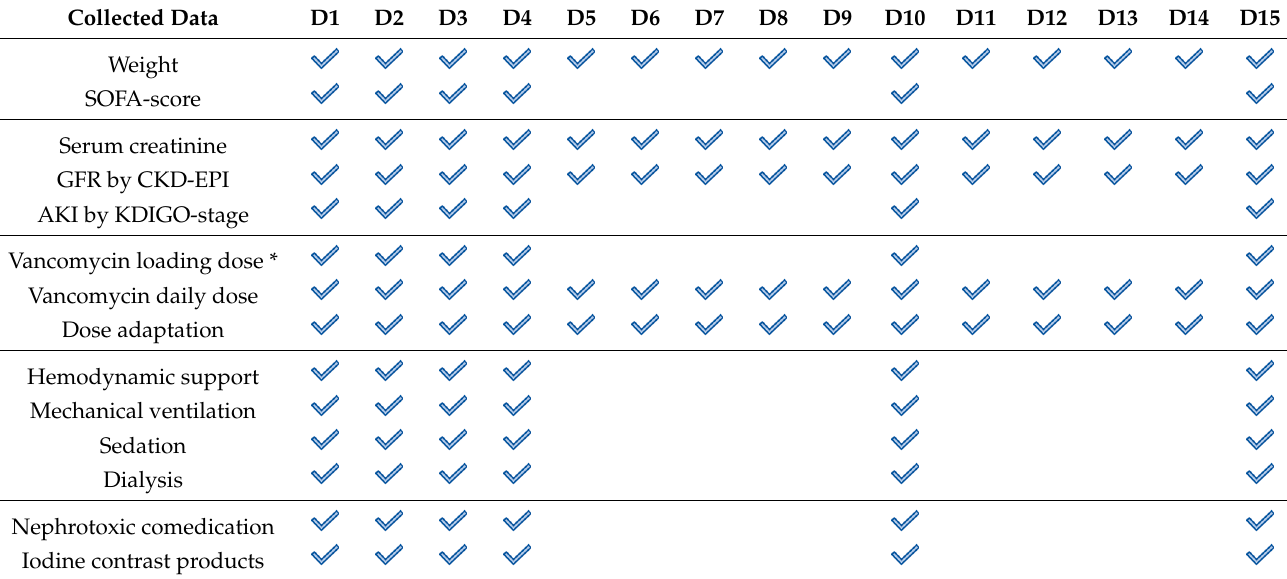
Table 1. Time of measurement of the di ff erent studied parameters. Table 1. Time of measurement of the different studied parameters. Table 1. Time of measurement of the different studied parameters. Table 1. Time of measurement of the different studied parameters. Table 1. Time of measurement of the different studied parameters. Table 1. Time of measurement of the different studied parameters. Table 1. Time of measurement of the different studied parameters. Table 1. Time of measurement of the different studied parameters. Table 1. Time of measurement of the different studied parameters. Table 1. Time of measurement of the different studied parameters. Table 1. Time of measurement of the different studied parameters. Table 1. Time of measurement of the different studied parameters. Table 1. Time of measurement of the different studied parameters. Table 1. Time of measurement of the different studied parameters. Table 1. Time of measurement of the different studied parameters. Table 1. Time of measurement of the different studied parameters. Table 1. Time of measurement of the different studied parameters. Table 1. Time of measurement of the different studied parameters. Table 1. Time of measurement of the different studied parameters. Table 1. Time of measurement of the different studied parameters. Table 1. Time of measurement of the different studied parameters. Table 1. Time of measurement of the different studied parameters. Table 1. Time of measurement of the different studied parameters. Table 1. Time of measurement of the different studied parameters. Table 1. Time of measurement of the different studied parameters. Table 1. Time of measurement of the different studied parameters. Table 1. Time of measurement of the different studied parameters. Table 1. Time of measurement of the different studied parameters. Table 1. Time of measurement of the different studied parameters. Table 1. Time of measurement of the different studied parameters. Table 1. Time of measurement of the different studied parameters. Table 1. Time of measurement of the different studied parameters. Table 1. Time of measurement of the different studied parameters. Table 1. Time of measurement of the different studied parameters. Table 1. Time of measurement of the different studied parameters. Table 1. Time of measurement of the different studied parameters. Table 1. Time of measurement of the different studied parameters. Table 1. Time of measurement of the different studied parameters. Table 1. Time of measurement of the different studied parameters. Table 1. Time of measurement of the different studied parameters. Table 1. Time of measurement of the different studied parameters. Table 1. Time of measurement of the different studied parameters. Table 1. Time of measurement of the different studied parameters. Table 1. Time of measurement of the different studied parameters. Table 1. Time of measurement of the different studied parameters. Table 1. Time of measurement of the different studied parameters. Table 1. Time of measurement of the different studied parameters. Table 1. Time of measurement of the different studied parameters. Table 1. Time of measurement of the different studied parameters. Table 1. Time of measurement of the different studied parameters. Table 1. Time of measurement of the different studied parameters. Table 1. Time of measurement of the different studied parameters. Table 1. Time of measurement of the different studied parameters. Table 1. Time of measurement of the different studied parameters. Table 1. Time of measurement of the different studied parameters. Table 1. Time of measurement of the different studied parameters. Table 1. Time of measurement of the different studied parameters. Table 1. Time of measurement of the different studied parameters. Table 1. Time of measurement of the different studied parameters. Table 1. Time of measurement of the different studied parameters. Table 1. Time of measurement of the different studied parameters. Table 1. Time of measurement of the different studied parameters. Table 1. Time of measurement of the different studied parameters. Table 1. Time of measurement of the different studied parameters. Table 1. Time of measurement of the different studied parameters. Table 1. Time of measurement of the different studied parameters. Table 1. Time of measurement of the different studied parameters. Table 1. Time of measurement of the different studied parameters. Table 1. Time of measurement of the different studied parameters. Table 1. Time of measurement of the different studied parameters. Table 1. Time of measurement of the different studied parameters. Table 1. Time of measurement of the different studied parameters. Table 1. Time of measurement of the different studied parameters. Table 1. Time of measurement of the different studied parameters. Table 1. Time of measurement of the different studied parameters. Table 1. Time of measurement of the different studied parameters. Table 1. Time of measurement of the different studied parameters. Table 1. Time of measurement of the different studied parameters. Table 1. Time of measurement of the different studied parameters. Table 1. Time of measurement of the different studied parameters. Table 1. Time of measurement of the different studied parameters. Table 1. Time of measurement of the different studied parameters. Table 1. Time of measurement of the different studied parameters. Table 1. Time of measurement of the different studied parameters. Table 1. Time of measurement of the different studied parameters. Table 1. Time of measurement of the different studied parameters. Table 1. Time of measurement of the different studied parameters. Table 1. Time of measurement of the different studied parameters. Table 1. Time of measurement of the different studied parameters. Table 1. Time of measurement of the different studied parameters. Table 1. Time of measurement of the different studied parameters. Table 1. Time of measurement of the different studied parameters. Table 1. Time of measurement of the different studied parameters. Table 1. Time of measurement of the different studied parameters. Table 1. Time of measurement of the different studied parameters. Table 1. Time of measurement of the different studied parameters. Table 1. Time of measurement of the different studied parameters. Table 1. Time of measurement of the different studied parameters. Table 1. Time of measurement of the different studied parameters. Table 1. Time of measurement of the different studied parameters. Table 1. Time of measurement of the different studied parameters. Table 1. Time of measurement of the different studied parameters. Table 1. Time of measurement of the different studied parameters. Table 1. Time of measurement of the different studied parameters. Table 1. Time of measurement of the different studied parameters. Table 1. Time of measurement of the different studied parameters. Collected Data Table 1. Time of measurement of the different studied parameters. Table 1. Time of measurement of the different studied parameters. Table 1. Time of measurement of the different studied parameters. Table 1. Time of measurement of the different studied parameters. Table 1. Time of measurement of the different studied parameters. Table 1. Time of measurement of the different studied parameters. Table 1. Time of measurement of the different studied parameters. Table 1. Time of measurement of the different studied parameters. Table 1. Time of measurement of the different studied parameters. Table 1. Time of measurement of the different studied parameters. Table 1. Time of measurement of the different studied parameters. Table 1. Time of measurement of the different studied parameters. Table 1. Time of measurement of the different studied parameters. Table 1. Time of measurement of the different studied parameters. Table 1. Time of measurement of the different studied parameters. Table 1. Time of measurement of the different studied parameters. Table 1. Time of measurement of the different studied parameters. Table 1. Time of measurement of the different studied parameters. Table 1. Time of measurement of the different studied parameters. Table 1. Time of measurement of the different studied parameters. Table 1. Time of measurement of the different studied parameters. Table 1. Time of measurement of the different studied parameters. Table 1. Time of measurement of the different studied parameters. Table 1. Time of measurement of the different studied